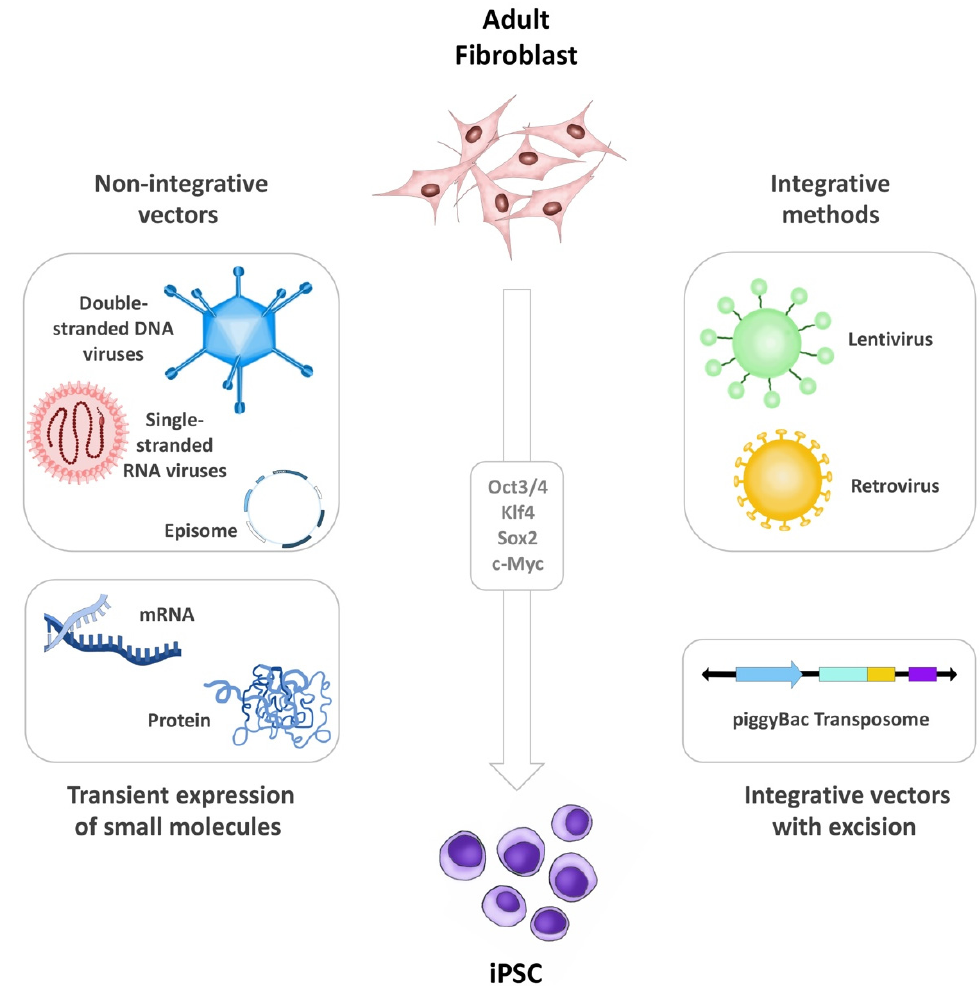
Figure 1. iPSC generation. Illustration summarizing the different methods for iPSC generation including non-integrative vectors, integrative methods, transient expression of small molecules, and integrative vectors that exhibit subsequent excision. The figure was designed and hand-drawn by CG-M.